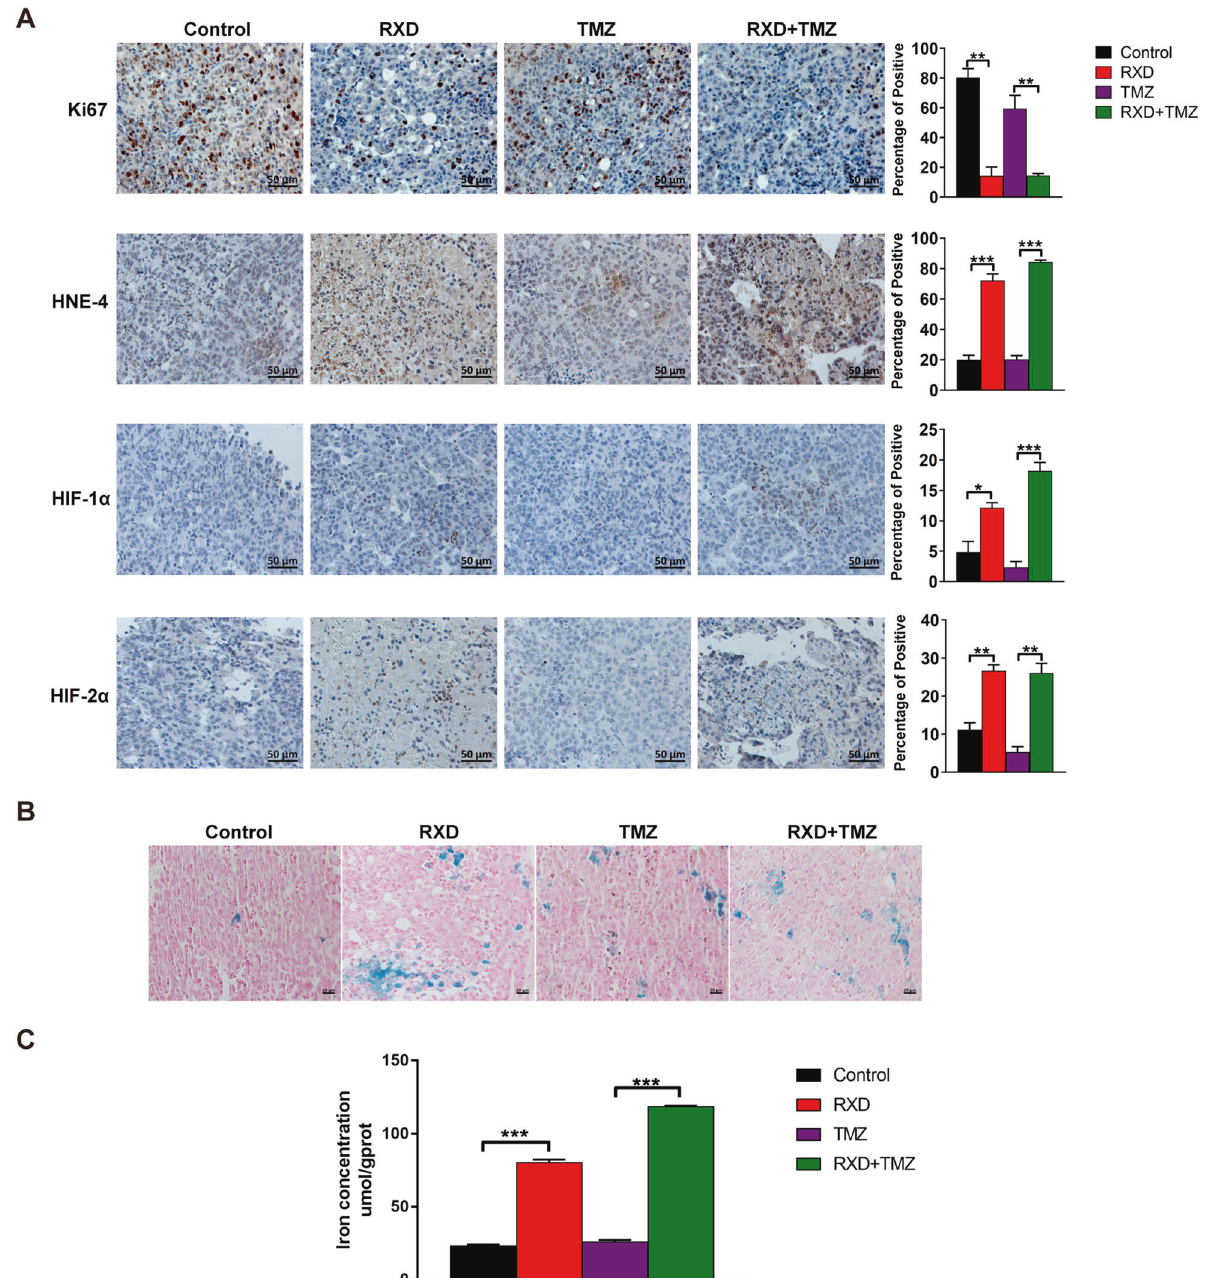
Prussian blue staining images of GBM tissues from each group. Scale bars: 20 μ m. C The iron concentrations of GBM tissues from mice in each group. * P < 0.05, ** P < 0.01, *** P <